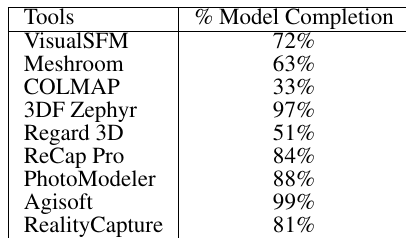
Table 4. Metadata of generated point clouds.